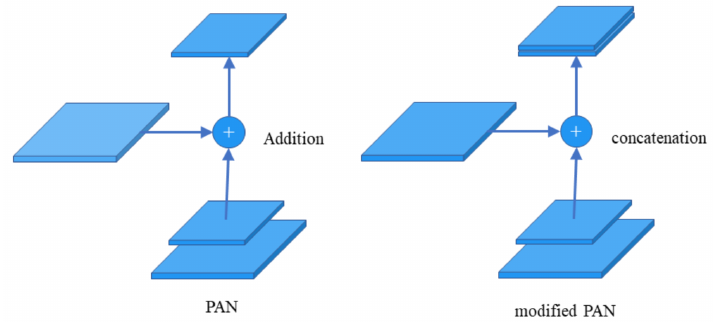
Figure 9. The difference between addition and concatenation fusion methods.